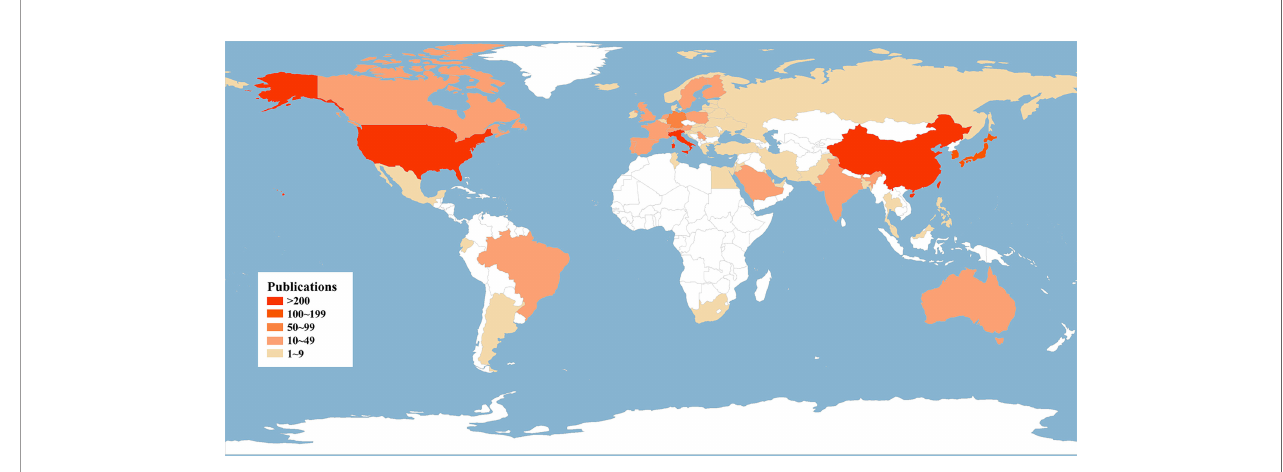
FIGURE 3 | Global geographical distribution of ATC